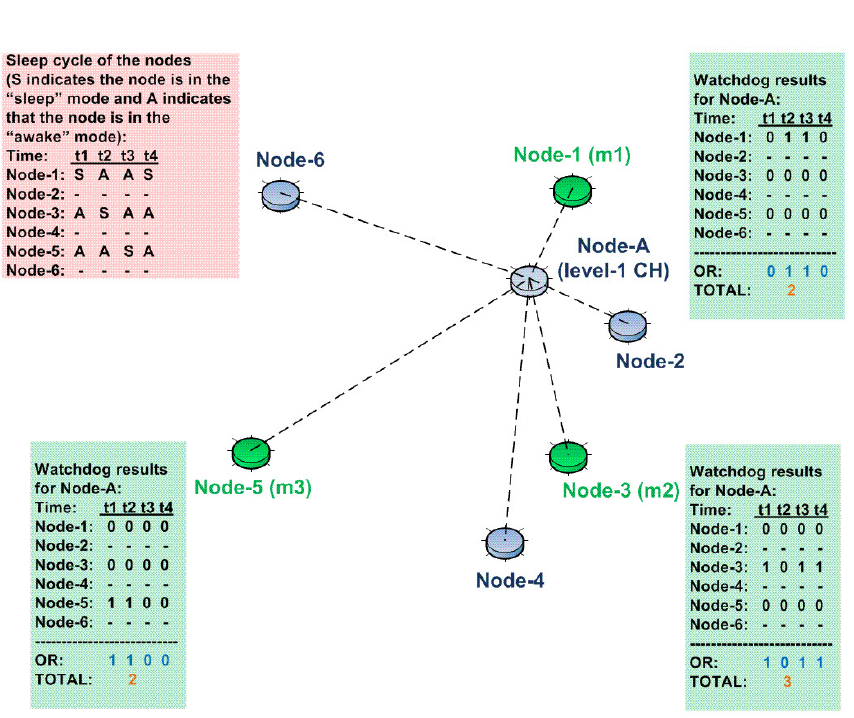
Figure 6. The usage of the monitoring group concept in our